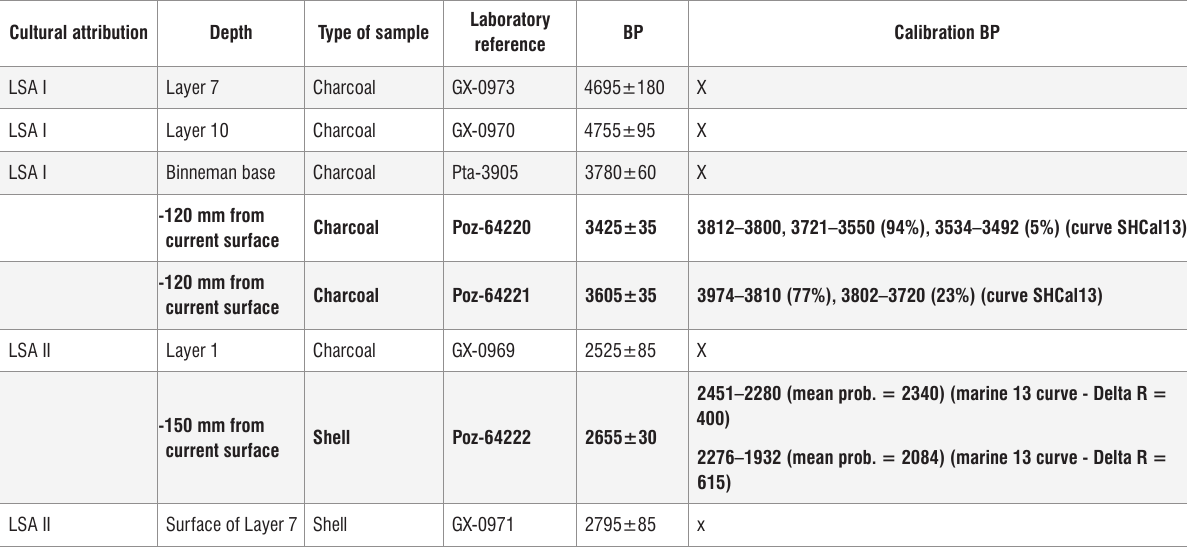
Uncalibrated radiocarbon dates from Later Stone Age (LSA) Phase I and II in Klasies River Cave 1 34,37 and new radiocarbon dates for the LSA